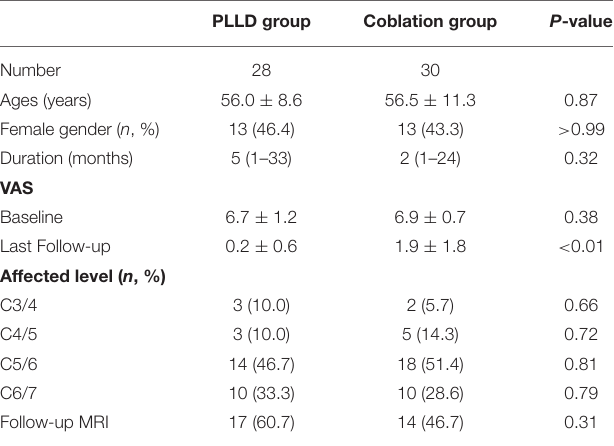
TABLE 3 | Clinical and demographic data of patients with cervical radicular